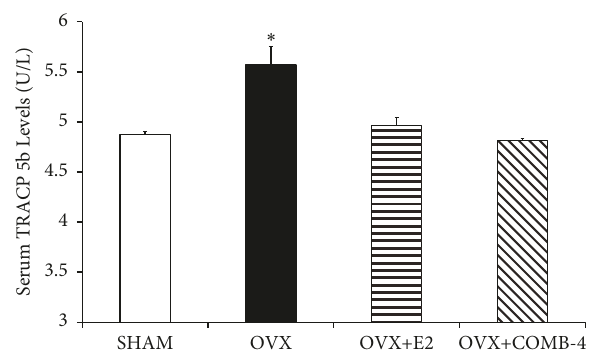
Figure 5: Level of serum tartrate-resistant acid phosphatase (TRACP 5b) after 100 days treatment with E2 or COMB-4 following OVX. Serum TRACP 5b (U/L + SEM) levels were determined by ELISA. ∗ p < 0.05 with respect to SHAM, OVX+E2, OVX+COMB-4. n = 8 per